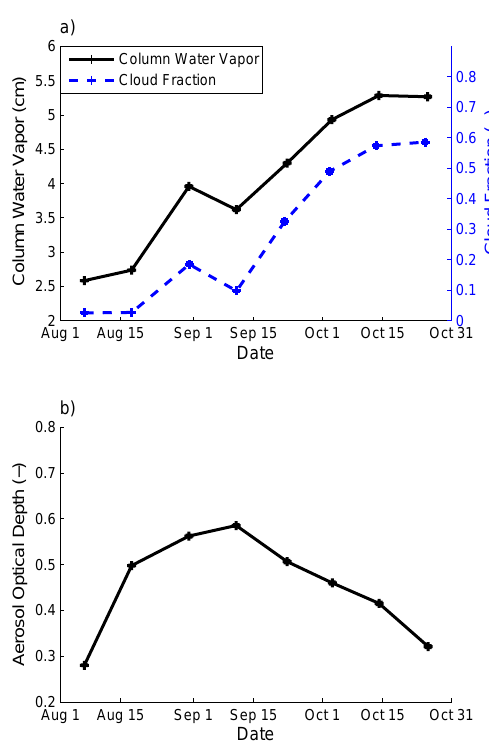
Fig. 3. (a) Column water vapor and warm cloud fraction binned by day of the year for the months of August through October, for the years 2004 through 2007. Data are accumulated into eight bins of equal width between 1 August and 31 October. (b) Aerosol optical depth at 550nm binned by day of the year for the same time period as in (a) . For (a) and (b) , only retrievals with AODs equal to or below 0.8 are included in the time series. Error bars are included but are too narrow to be visible. The number of retrievals included in each bin is provided in Supplement